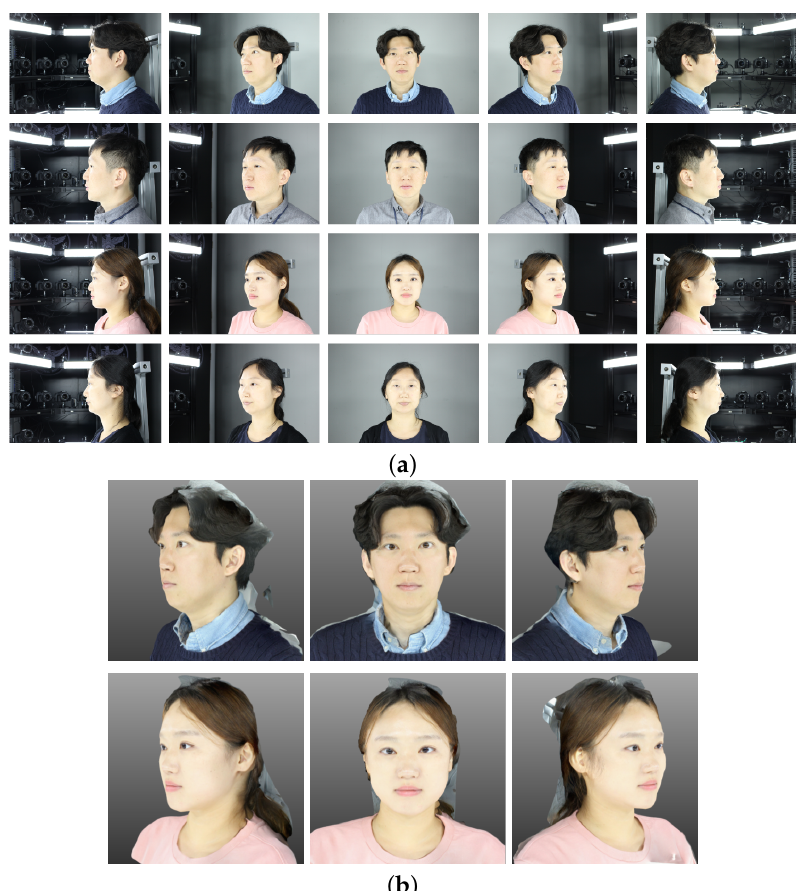
Figure 2. Example of dataset construction: ( a ) obtained images; ( b ) 3D face model based on 3D image reconstruction.